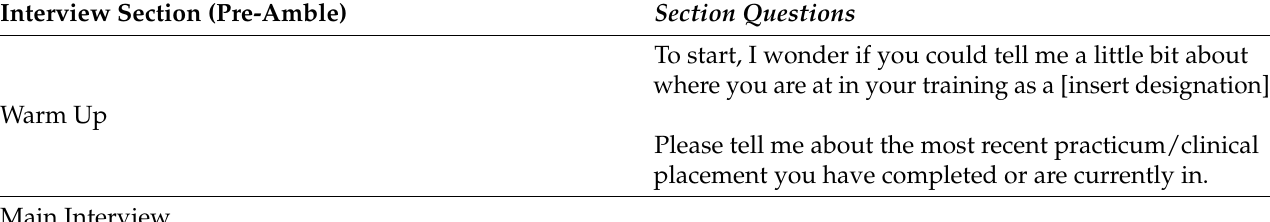
Table 1. Semi-structured interview